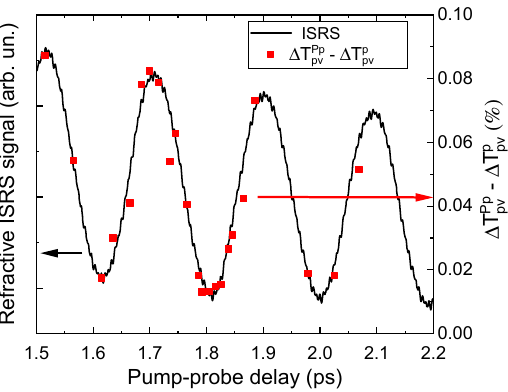
Figure 6. ∆ T Pp pv − ∆ T p pv Z-scan difference signal as a function of the pump–probe delay (squares), together with the corresponding portion of the ISRS signal measured with the Kerr lens method (continuous